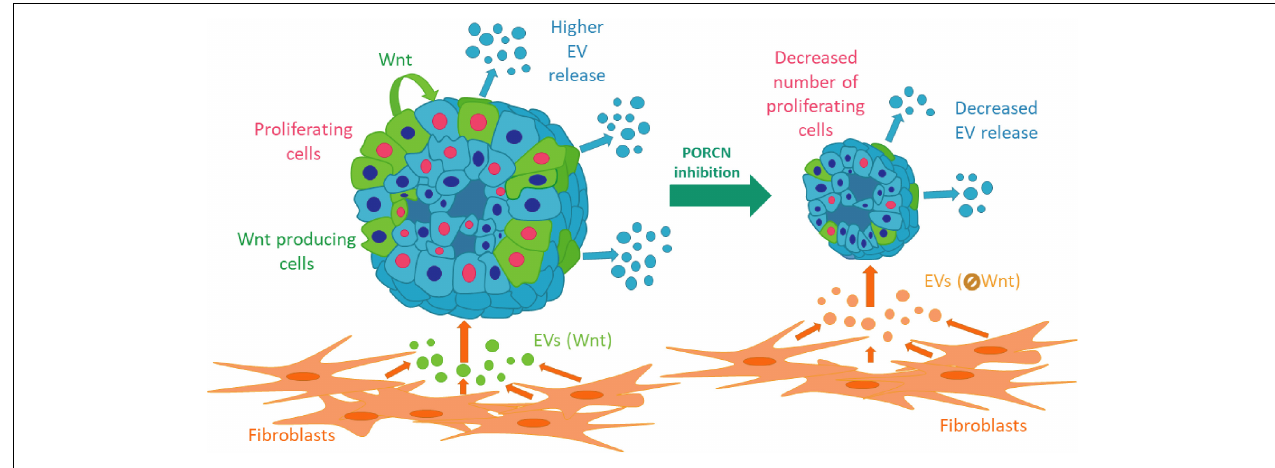
FIGURE 7 | A schematic representation of our